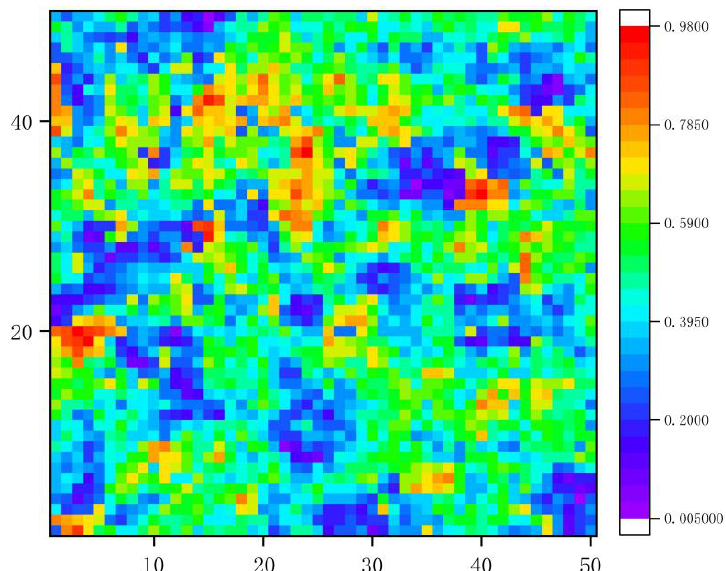
Figure 6. Simulated oil spill distribution map.